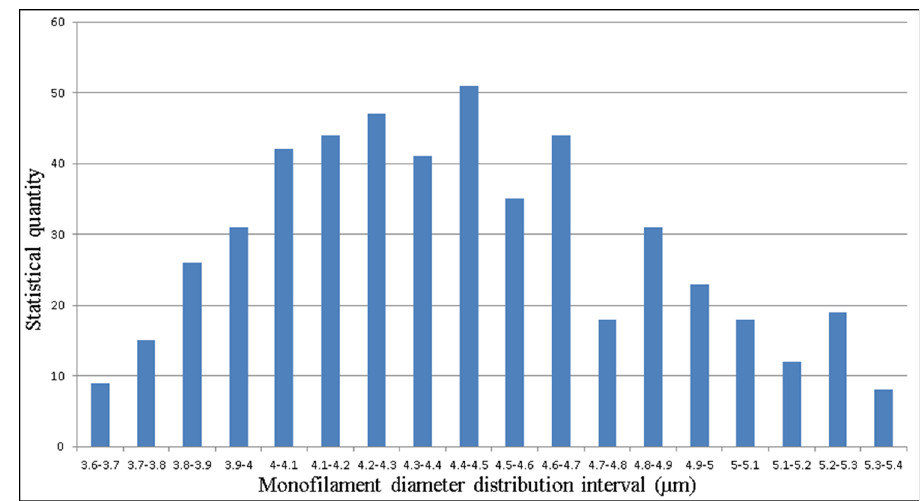
Figure 8: Mono fi lament diameter distribution for BC1500 glass yarn.